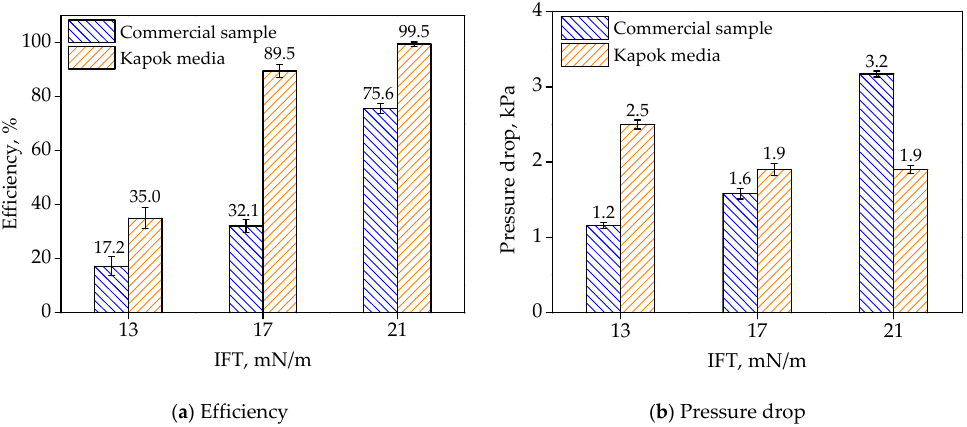
Figure 11. The diesel/water separation performance of filter media under different IFT.